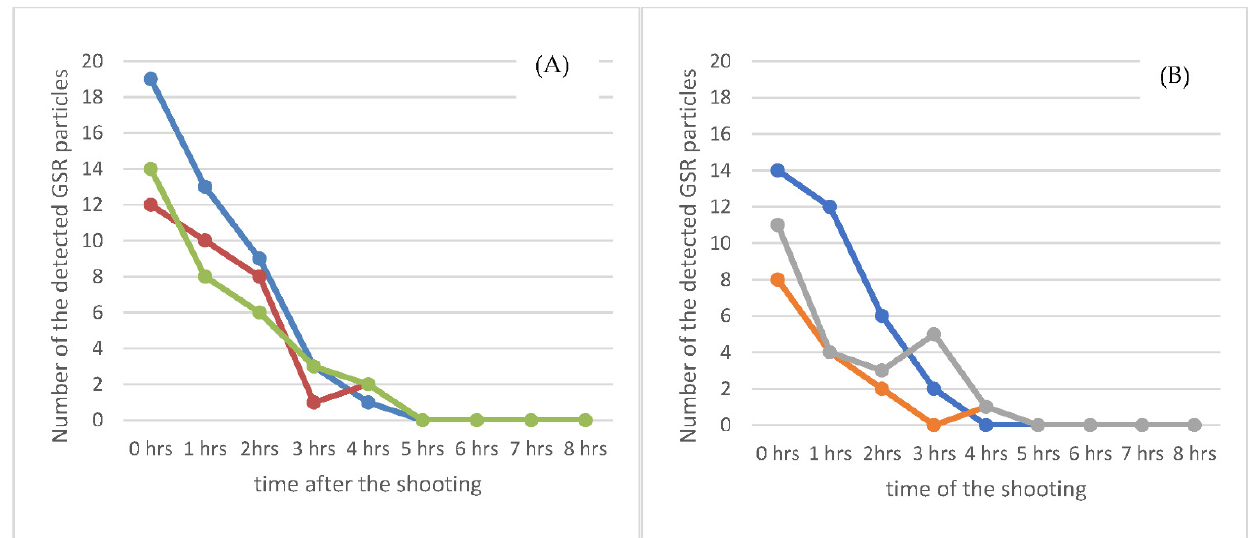
Figure 4. Number of particles characteristic of GSR as a function of time after shooting with low- caliber ammunition: Walther PPK pistol (7.65 × 19 mm) (blue line), Glock 19 pistol (9 × 19 mm) (red and orange line), and Zastava M70 pistol (7.65 × 17 mm) (green and grey line). The experiments were carried out during: ( A ) the winter season and ( B ) the summer season.